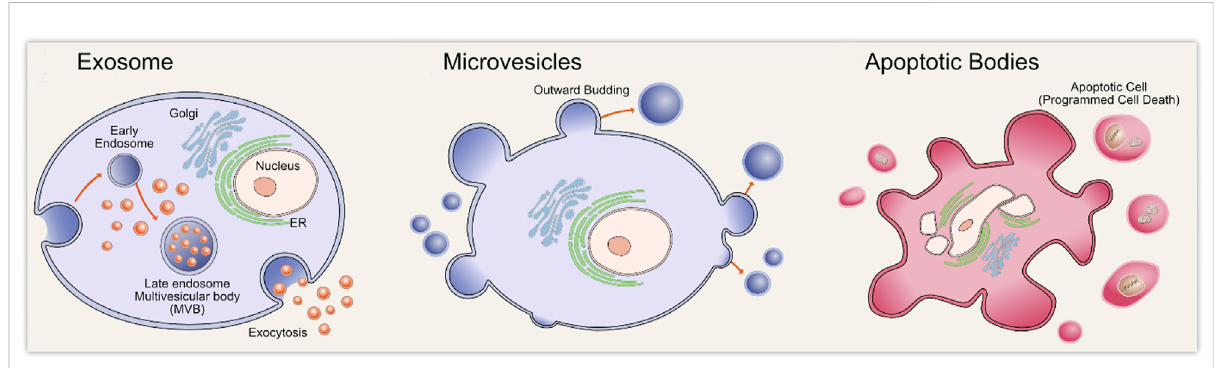
FIGURE 2 Diagrammatic overview of the three types of extracellular vesicles biogenesis including exosomes biogenesis, microvesicles biogenesis, and apoptotic bodies biogenesis. Reprinted with permission from Gurunathan et al. (2019).